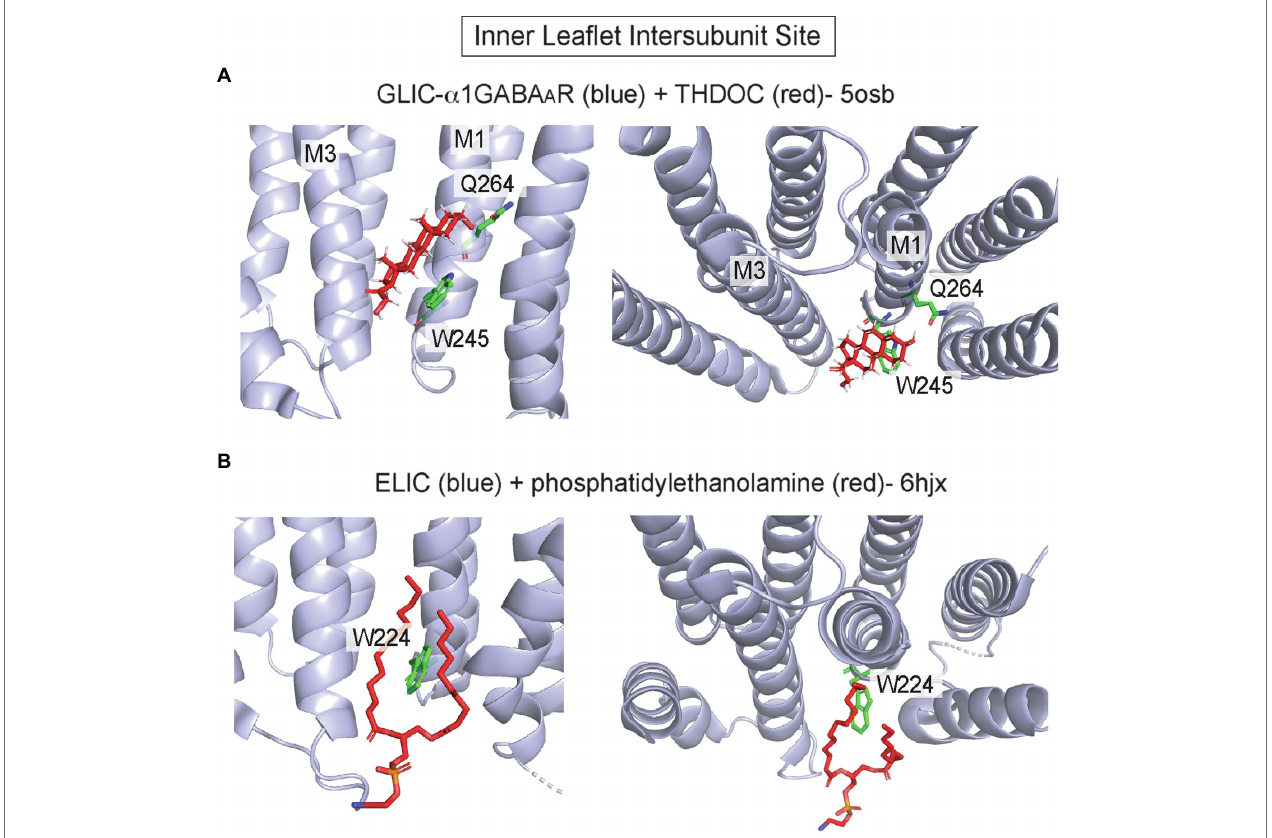
FIGURE 3 | Inner leaflet intersubunit binding site in pLGICs. (A) GLIC- α 1GABA A R chimera at pH 4.5 with THDOC (pdb 5osb). Q264 forms a hydrogen bond interaction with the 3-hydroxyl group of the neurosteroid, and W245 forms a hydrophobic ring stacking interaction with the steroid backbone. (B) Apo ELIC with phosphatidylethanolamine (pdb 6hjx). Shown is W224, which is a highly conserved tryptophan in pLGICs that interacts with neurosteroids (A) and forms this lipid binding